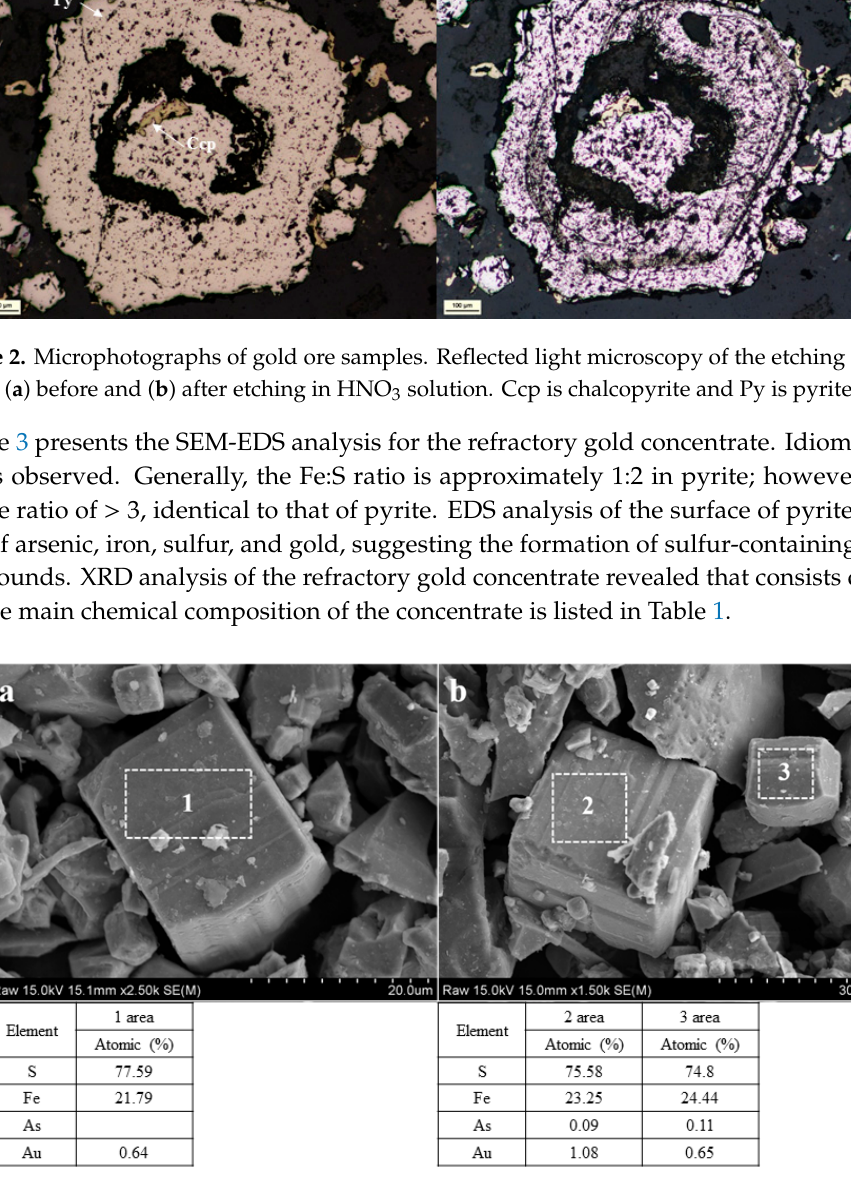
Figure 3. SEM-EDS (Scanning Electron Microscopy-Energy-dispersive X-ray spectroscopy) of pyrite in the refractory gold concentrate.